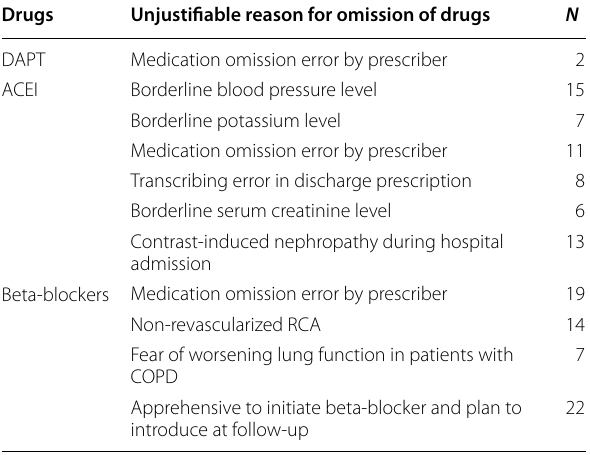
DAPT dual antiplatelet therapy, ACEI angiotensin-converting enzyme inhibitor, RCA right coronary artery, COPD chronic obstructive pulmonary